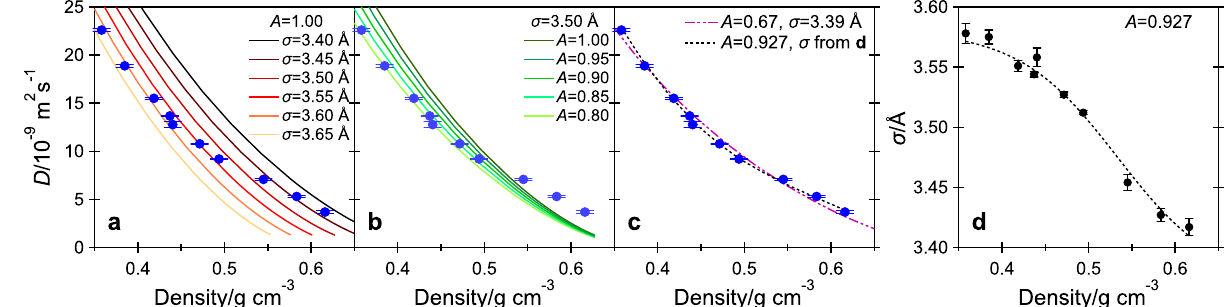
Fig. 4 Comparison with the molecular dynamics simulations of the hard-sphere fl uid. a – c Self-diffusion coef fi cient D from our measurements of methane (full circles) and from the simulation results for the hard-sphere fl uid reported in ref. 48 (lines), as a function of density. Simulated values are reported for: a A = 1.00 and six different values of the hard-sphere diameter σ , b σ = 3.5 Å and fi ve different values of the translation-rotation coupling parameter A , and c A = 0.67 and σ = 3.39 Å , A = 0.927 and σ from the fi t of d . d σ values for which Eq. (3) is satis fi ed with A = 0.927, as a function of density, and the best sigmoidal fi t (dashed line). Error bars correspond to one